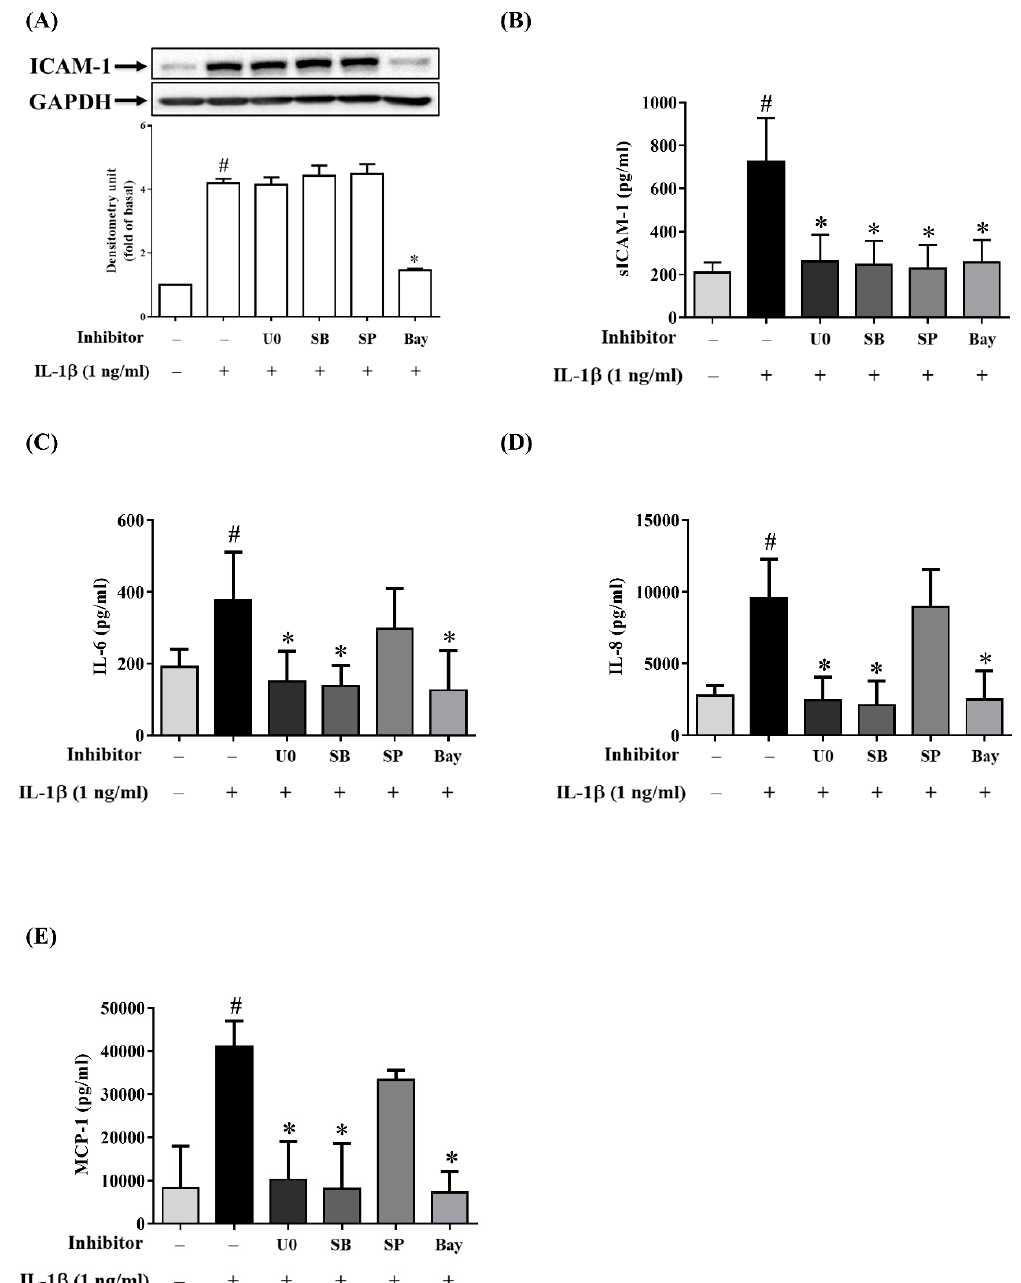
Figure 6. Inhibitory e ff ects of MAPKs and NF- κ B inhibitors on the protein expression of ICAM-1, sICAM-1, IL-6, IL-8 and MCP-1 in IL-1 β -stimulated ARPE-19 cells. ARPE-19 cells were pretreated with 10 µ M U0126 (U0), 10 µ M SB202190 (SB), 10 µ M SP600125 (SP) or 5 µ M Bay11-7082 (Bay) for 1 h prior to stimulation with 1 ng / mL IL-1 β for 24 h. ( A ) ICAM-1 protein expression was measured by Western blotting and quantified using Image Lab software. ( B ) The levels of sICAM-1, ( C ) IL-6, ( D ) IL-8 and ( E ) MCP-1 were detected by ELISA. The data are expressed as mean ± SD of three independent experiments. # p < 0.05 versus control cells. * p < 0.05 versus IL-1 β -stimulated cells.